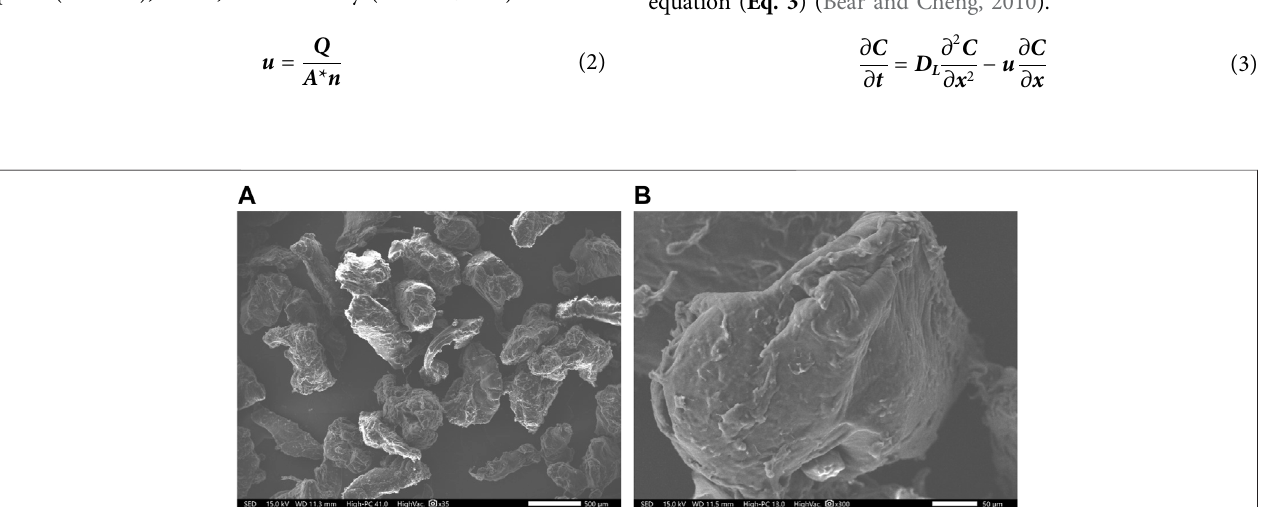
Frontiers in Environmental Science |